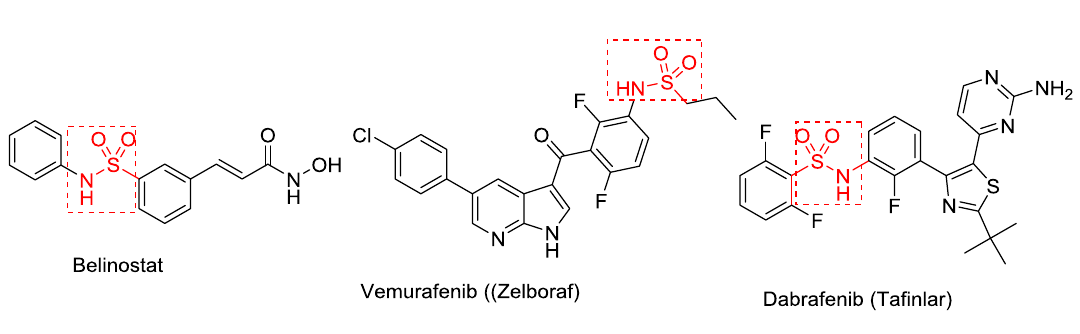
Figure 1. Natural spiro-indole containing compounds.